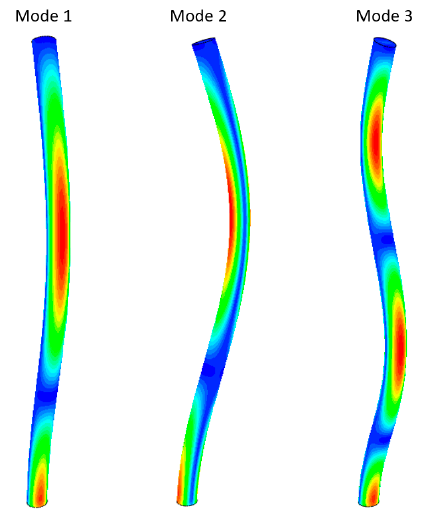
Figure 10. Numerical results—buckling mode of a steel rod under FEA.